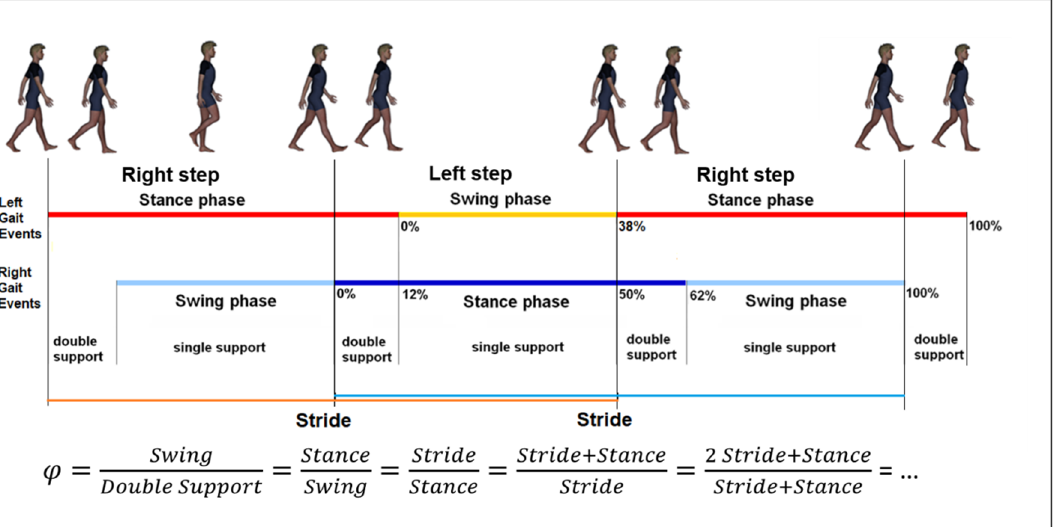
Figure 2. Schematic representation of the Gait Cycle and the equation of autosimilarity, defined as when the proportion between stride and stance durations is equal to the golden ratio ( φ ).